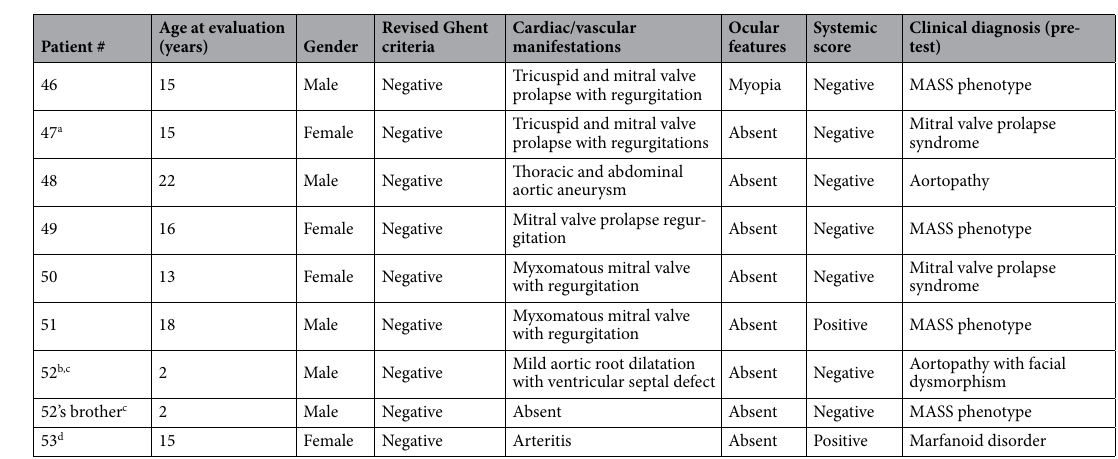
Table 3. Patients with no clinically relevant variant in genes known to cause Marfan syndrome and related disorders. Revised Ghent criteria ‘negative’ indicates non-fulfillment. Systemic score ‘positive’ indicates systemic involvement (score ≥ 7) and ‘negative’ suggests no systemic involvement (score < 7). MASS phenotype Mitral valve, Aorta, Skin, and Skeletal features. a Patient 47 had poor scholastic performance. b Patient 52 had developmental delay. c The difference in the phenotypes of patient 52 and his brother could suggest variable expression. d Patient 53 had microtia and perauricular